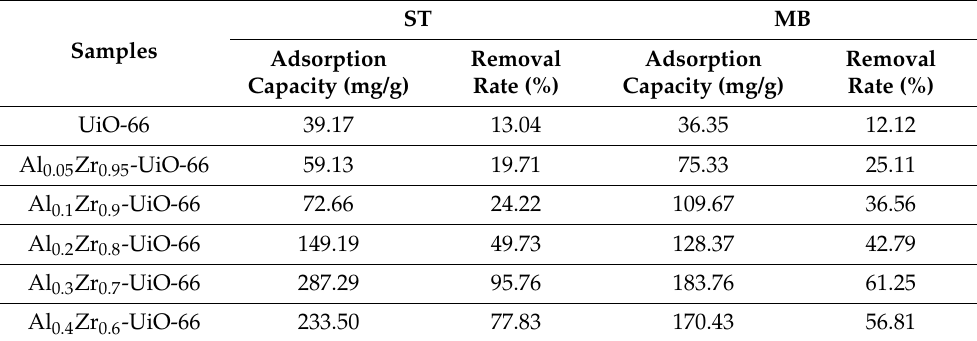
Figure 6. The UV-vis absorption spectra of two dyes ( a ) ST and ( b ) MB before and after adsorption on the pristine UiO-66 and Al x Zr (1 − x) -UiO-66 MOFs (adsorption time: 12 h, initial dye concentration: 300 mg/L, adsorbent dosage: 1 g/L, adsorption temperature: 30 °C). Table 2. The adsorption amount and removal rate of the two cationic dyes on UiO-66 and Al x Zr (1 − x) - UiO-66